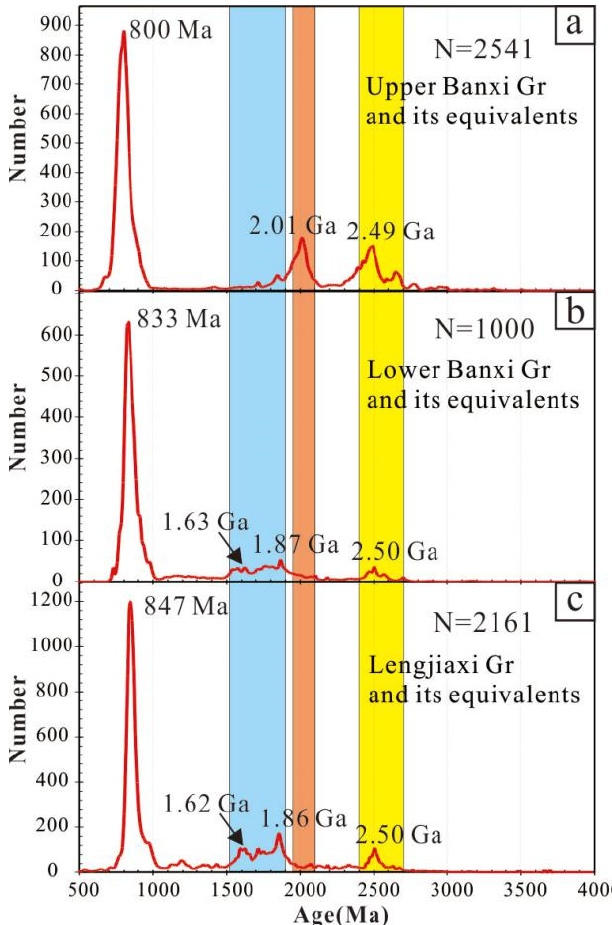
Figure 11. A comparison of age probability histograms of representative zircon age distributions for the lower Banxi Group and its equivalents ( a ), the upper Banxi Group and its equivalents ( b ), and the Lengjiaxi Group and its equivalents ( c ) along the WJO, respectively. Data from: [18,23,36,39,43,44,52,55,68–76,95–97,122–124] and this study. 207 Pb/ 206 Pb ages are used for zircons with ages >1000 Ma, 206 Pb/ 238 U ages are used for zircons younger than 1000 Ma.